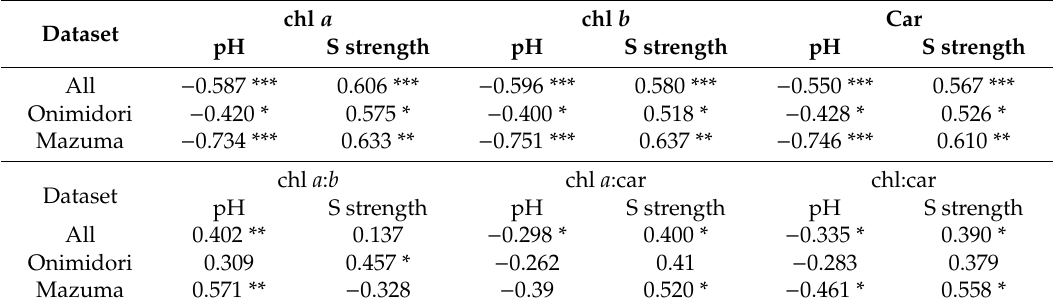
Table 1. Correlation between pH or S strength and chl a , b , car, and their ratios.